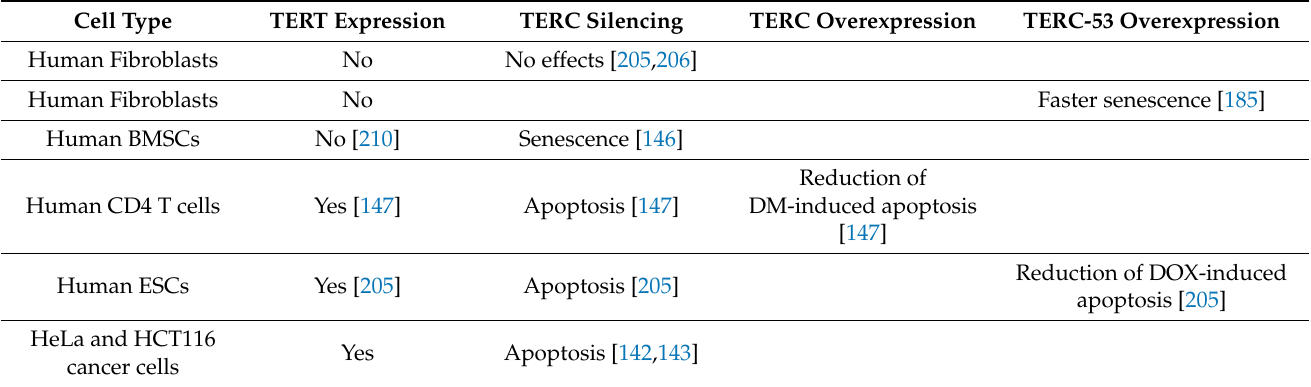
Table 1. Effects of TERC silencing and overexpression in different cell types. BMSCs: bone marrow stromal cells; ESC: Embryonic stem cells; DM: Dexamethasone; DOX: